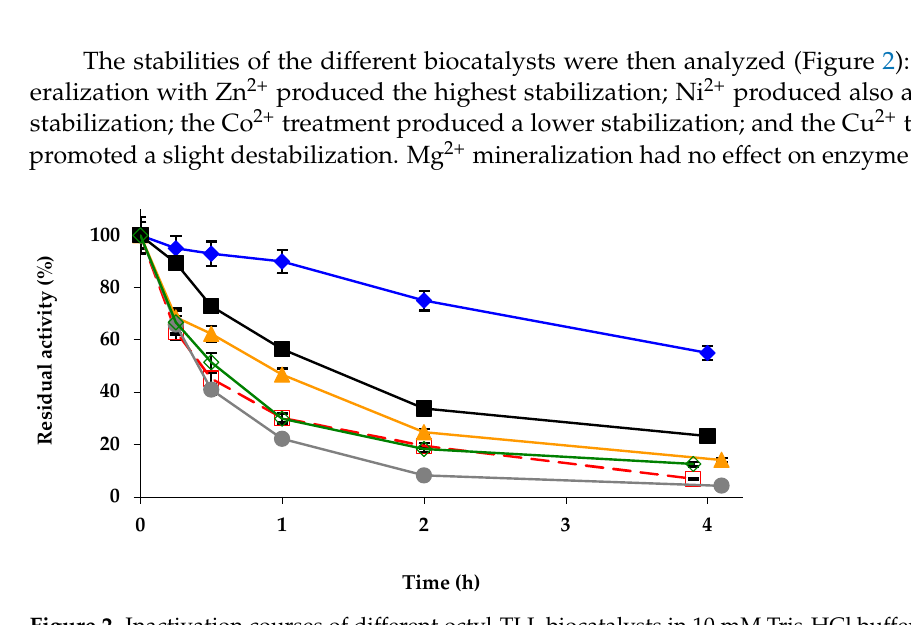
Figure 2. Inactivation courses of different octyl-TLL biocatalysts in 10 mM Tris-HCl buffer at pH 7.0 and 75 ◦ C. Other specifications are described in Methods. Unmodified octyl-TLL (empty squares and dashed and red line); octyl-TLL modified with 1% glutaraldehyde (solid rhombus and solid blue line); amination using 2 M ethylenediamine (solid triangles and solid orange line); 1 mM picrylsulfonic acid (solid circles and solid grey line); 10% polyethylenimine (solid squares and solid black line); 10% dextran sulfate (empty rhombus and solid green line).